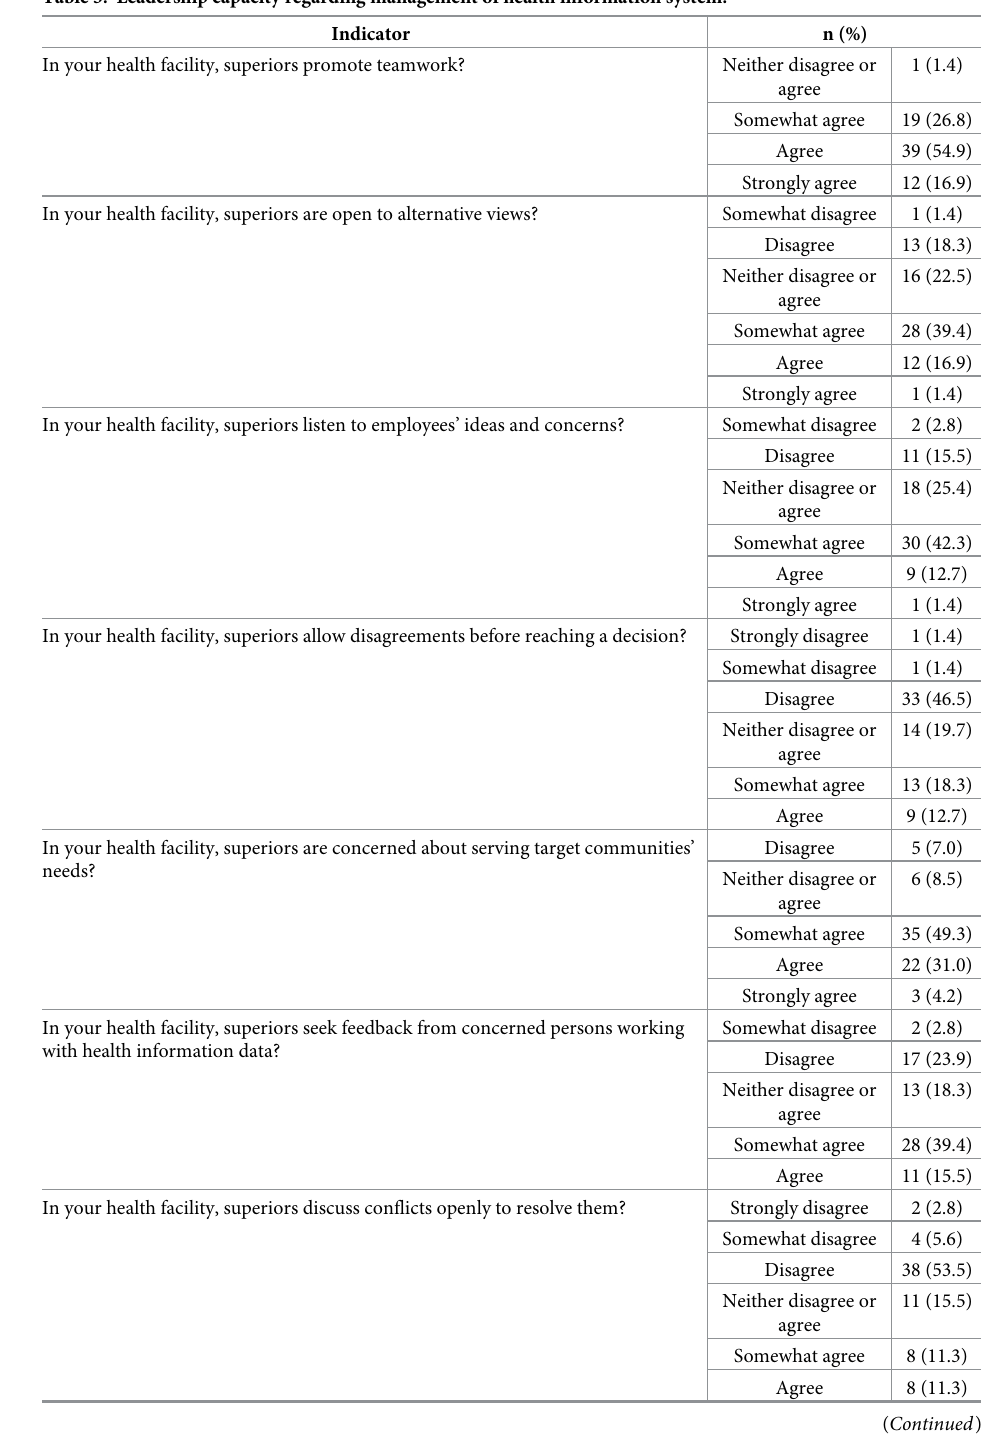
Table 5. Leadership capacity regarding management of health information